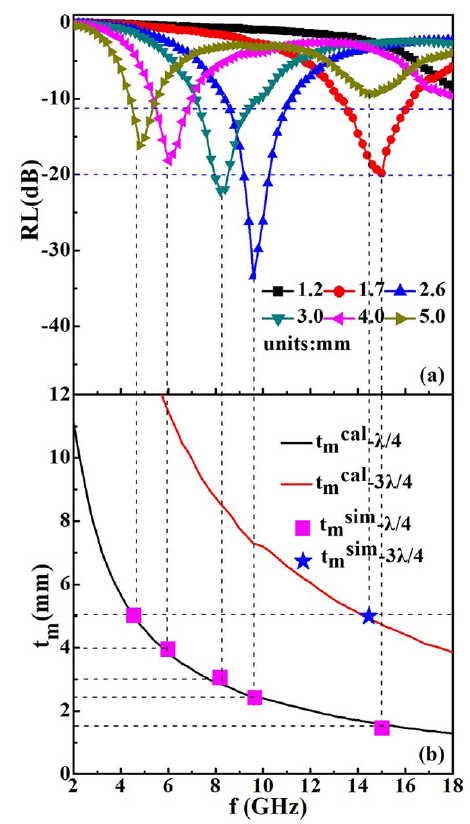
Figure 6. (a) Dependence of RL on frequency at various thicknesses for the FCC-Co/C nanocapsules-paraffin composites; and (b) Dependence of λ/4 and 3λ/4 thickness on frequency for the FCC-Co/C nanocapsules-paraffin